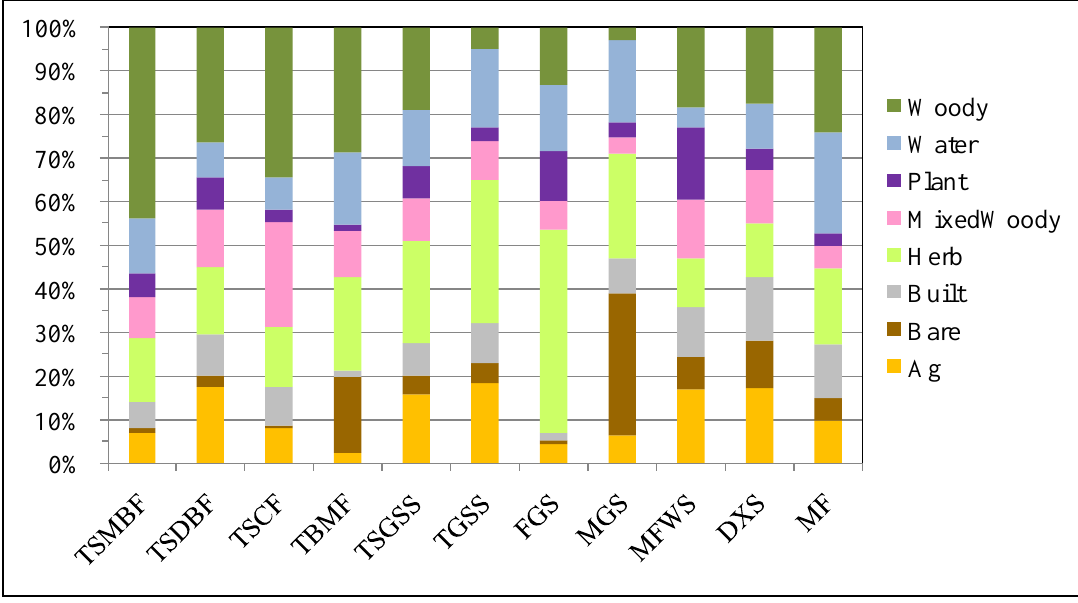
Figure 8. Class distribution of samples within each of the eleven biomes in Latin America and the Caribbean. See Table 2 for full names of biome